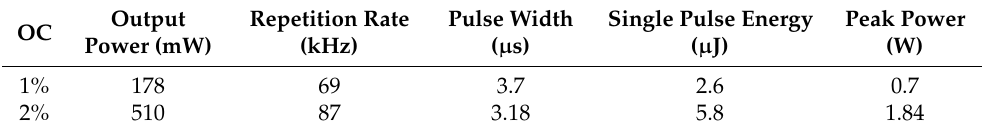
Figure 4. ( a ) The dependence of repetition rates and pulse widths on pump power. ( b ) The depen- dence of single pulse energy and peak power on pump power. Table 1. Parameters of the pulsed Yb:CALGO laser under different OCs.